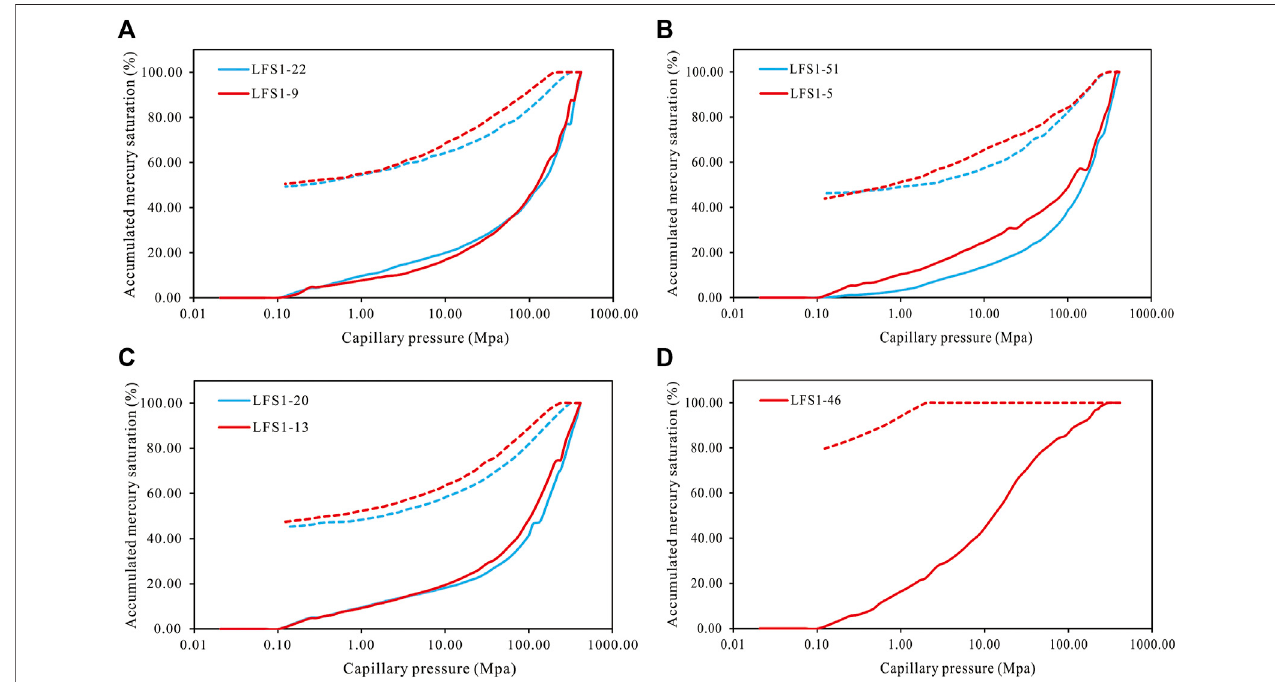
FIGURE 4 | Curves of mercury intrusion – extrusion from different lithofacies for shale samples in the Shahezi Formation. (A) ORS shale; (B) ORM shale; (C) ORA shale; and (D) ORC shale.